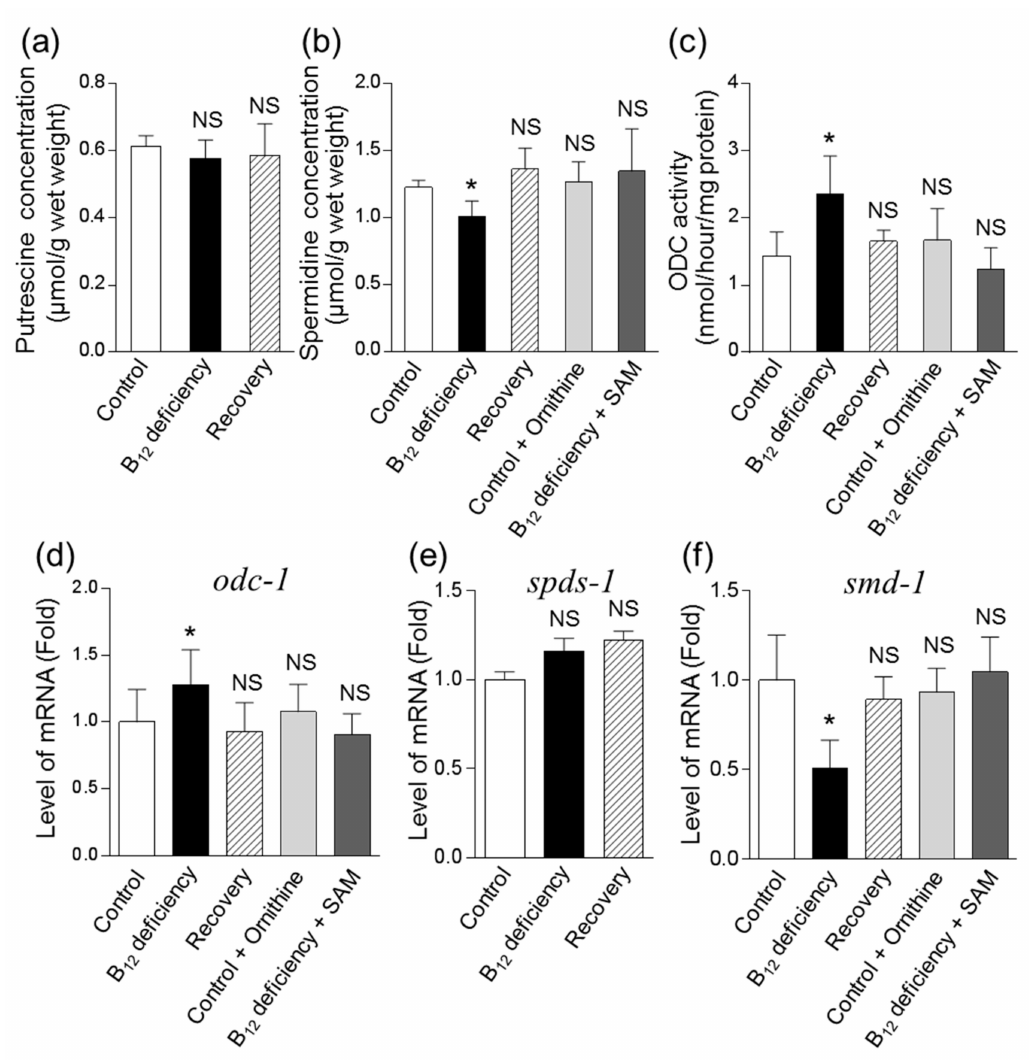
Figure 6. E ff ects of vitamin B 12 deficiency on polyamine (putrescine and spermidine) levels and the mRNA expression levels of genes encoding enzymes involved in the biosynthetic pathway of spermidine from ornithine in C. elegans . Putrescine ( a ) and spermidine ( b ) levels and ornithine decarboxylase (ODC, c ) activity were determined in control and B 12 -deficient worms using HPLC. Control worms and B 12 -deficient worms were grown in ornithine (final concentration 10 µ M)-supplemented and S-adenosylmethionine (SAM) (final concentration 1 µ M)-supplemented medium for three days. Ornithine-supplemented control worms and SAM-supplemented B 12 -deficient worms were also analyzed and shown as Control + Ornithine and B 12 deficiency + SAM, respectively. The mRNA expression levels of the orthologous genes of human ODC ( odc-1 ), spermidine synthase ( spds-1 ), and S-adenosylmethionine decarboxylase ( smd-1 ) represent ( d ), ( e ), and ( f ), respectively. Data represent the mean ± SEM of three independent experiments. * p < 0.05 versus Control group. NS represents no significant di ff